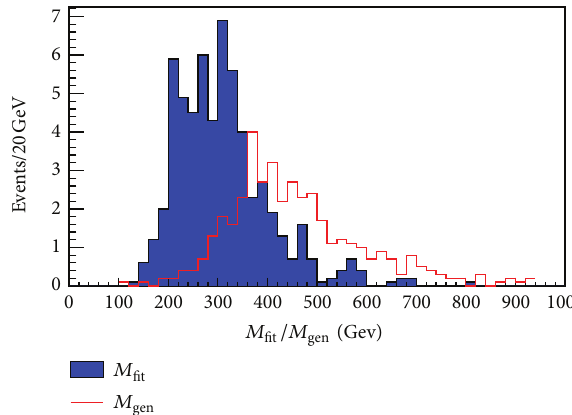
󸀠 → 2𝑊 + 2𝑏 signature Figure 21: Comparison between 𝑀 󸀠 → 2𝑊 + 6𝑏 reconstructed 𝑡 󸀠 mass using the CMS method—(in blue) and 𝑀 signature 𝑚 ( left side ) = 𝑚 ( right side ) —the reconstructed 𝑡 󸀠 mass using the method suggested in [149]—(in red), for the 𝑝𝑝 → 𝑡 󸀠 𝑡 signature with 𝑚 𝑡 󸀠 = 450 GeV at the LHC with a c.m. of 7 TEV and ∫ 𝐿𝑑𝑡 = 1𝑓𝑏 −1 , in the semileptonic channel ( 1ℓ + 𝑛𝑗 + (cid:2)(cid:2) 𝐸 text. Figure taken from